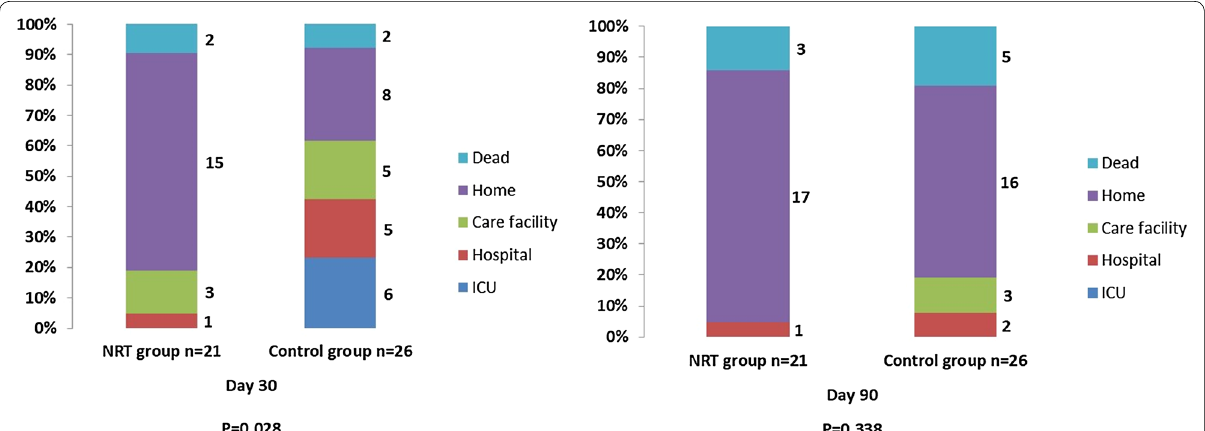
Fig. 2 Patient destinations at day 30 and day 90 comparing nicotine replacement therapy and placebo group. Data are presented as numbers. ICU intensive care unit, NRT nicotine replacement